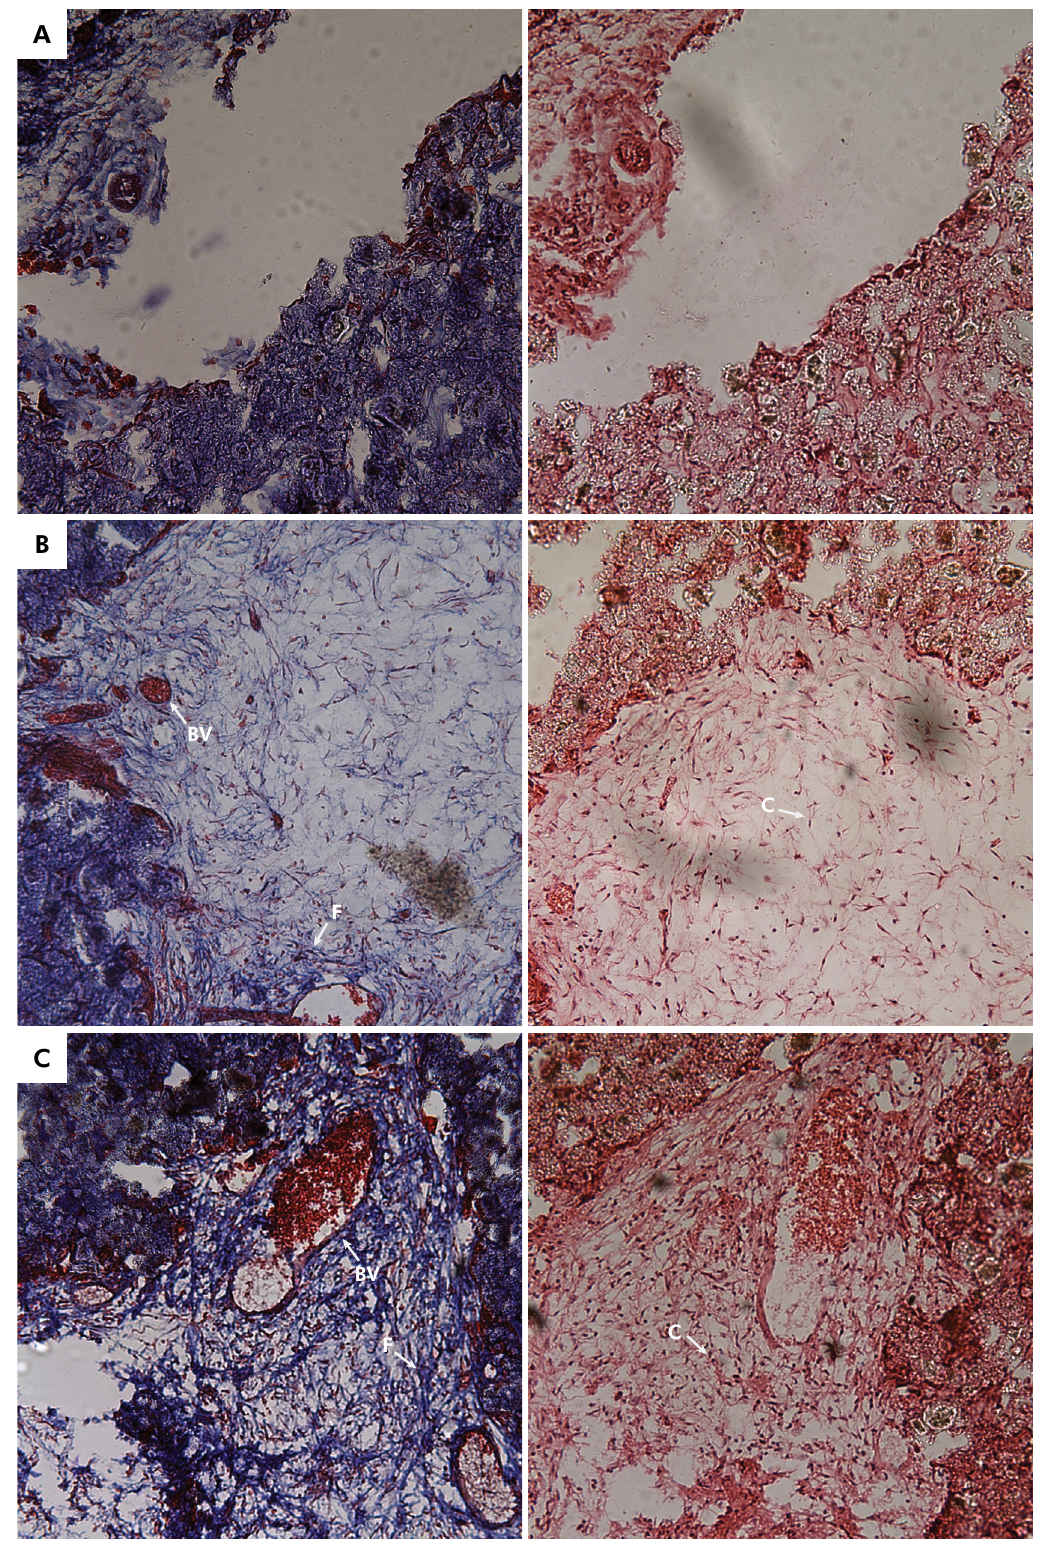
Figure 4. Histological examination of the harvested complexes at 8 weeks. A: empty scaffold; B: DFCs + scaffold; C: DFCs + scaffold + LIPUS. C, cell; F, newly formed fibrous tissue; BV, newly formed blood